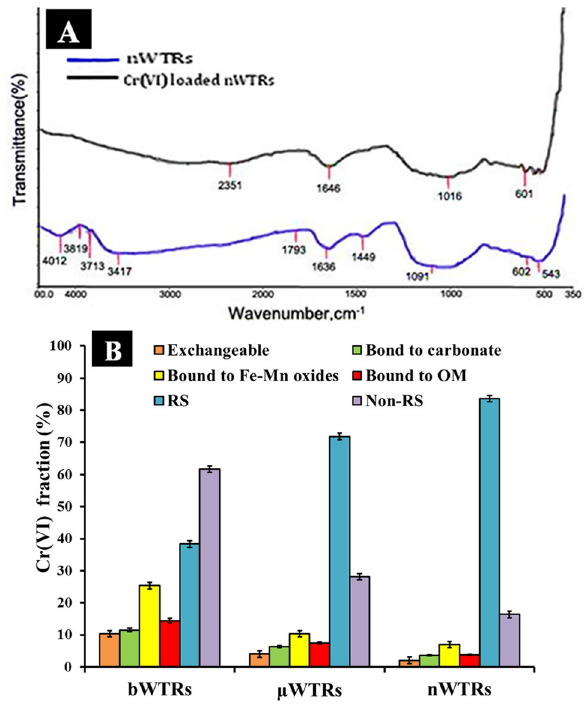
Figure 2. FTIR spectrum analysis of nWTRs before and after Cr(VI) adsorption ( A ), and Fractionation of adsorbed Cr (VI) on different particle sizes of WTRs Notice that Cr (VI) adsorbed on nWTRs was mostly associated with the less mobile fraction (residual fraction, RS), which indicates the high capability of nWTRs to immobilize Cr (VI) ( B